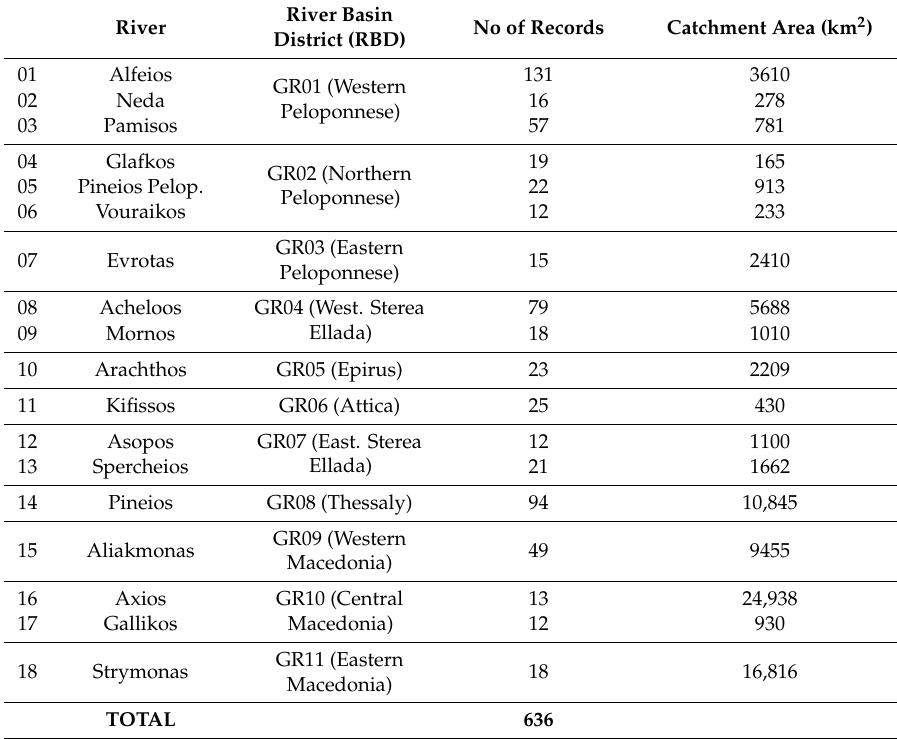
Figure 1. Location of monitoring sites per river basin. Table 1. List of studied rivers per River Basin District and the number of measurements obtained from the National River Monitoring Program, as well as their catchment area and annual discharge [20].